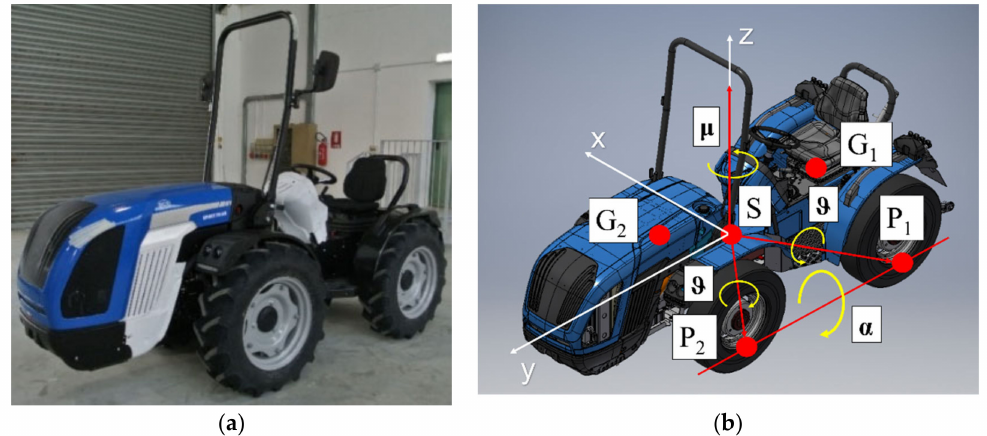
Figure 3. Compact articulated tractor: ( a ) Actual tractor in the straight configuration; ( b ) Graphical representation of the tractor parameters assumed in modelling: P 1 , P 2 , G 1 , G 2 and S are the five characteristics points defined in the modeling approach related to the geometrical tractor configuration, µ is the yaw angle, ϑ is the roll angle and, α is the tractor stability